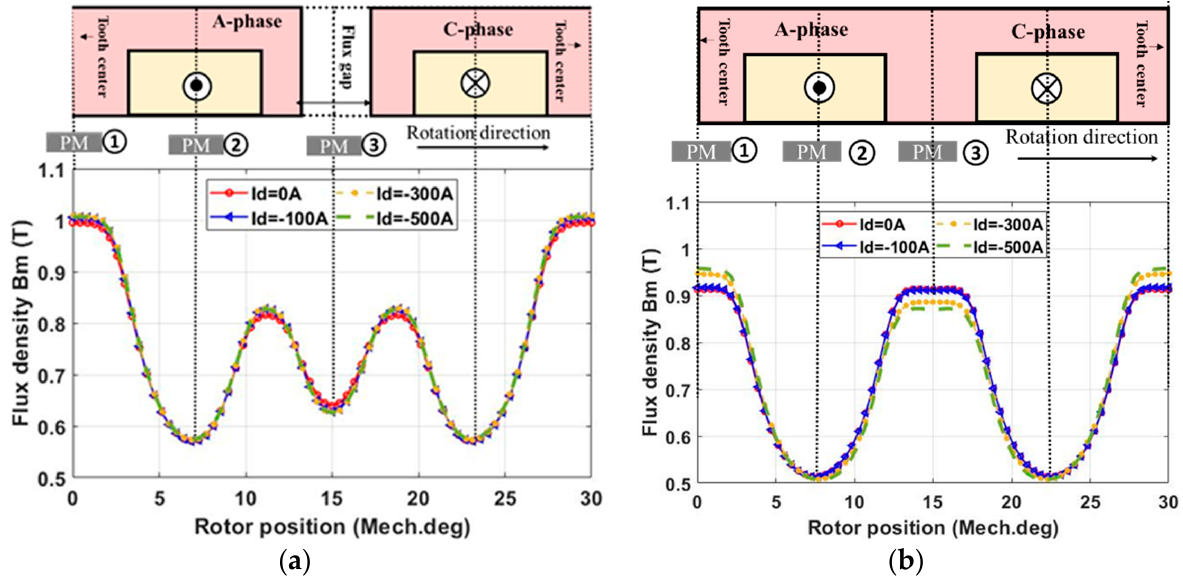
Figure 9. Magnet flux density (radial component) generated by PM source at point A within the selected PM vs. rotor position for the ( a ) modular and ( b ) non-modular machines.